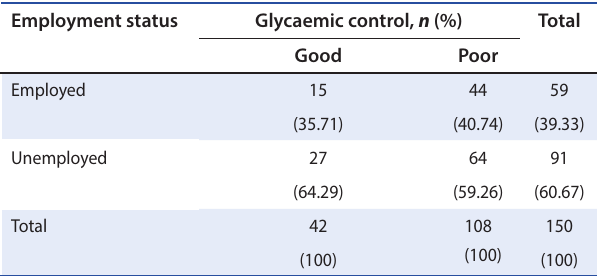
Table 4: Employment status and glycaemic